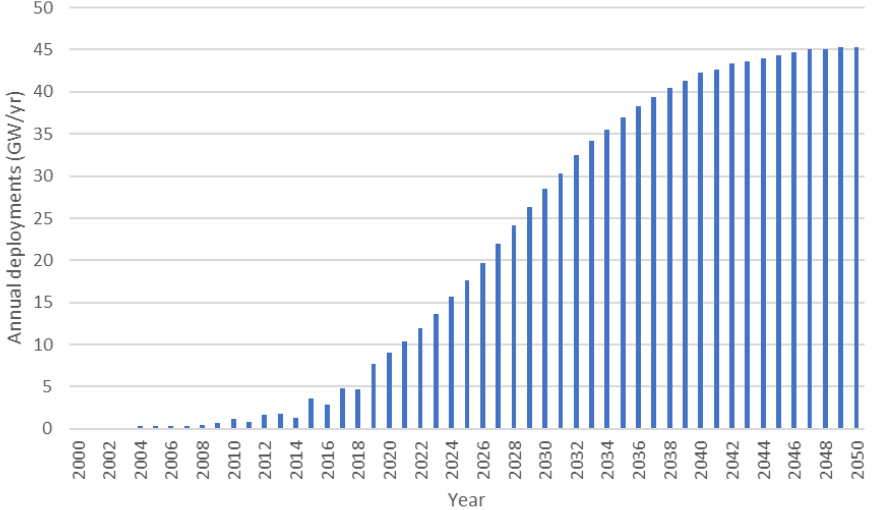
Figure 5. Annual offshore wind capacity, historical data, and projections. Adapted from [36].